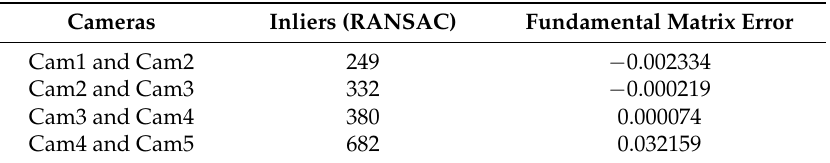
Table 5. Results of matching images from individual cameras.